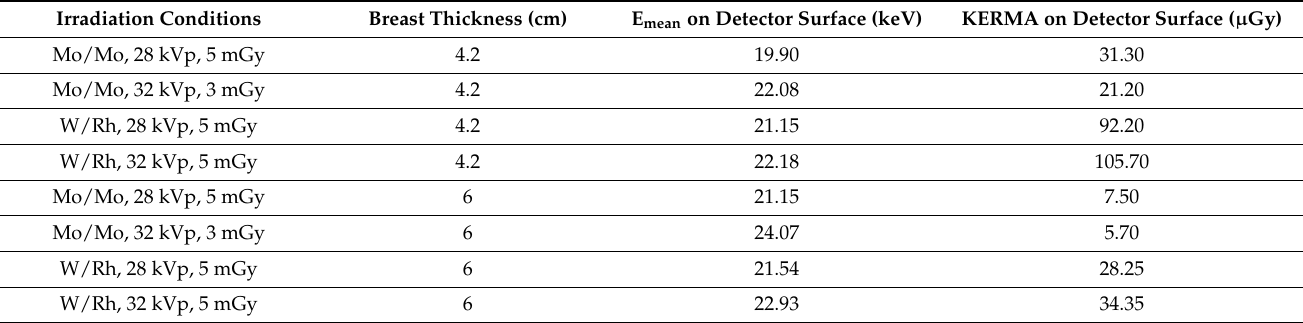
Table 2. The mean energy of the X-ray photon spectra and the Kerma on the detector surface for the breast thicknesses of 4.2 cm and 6 cm used in this